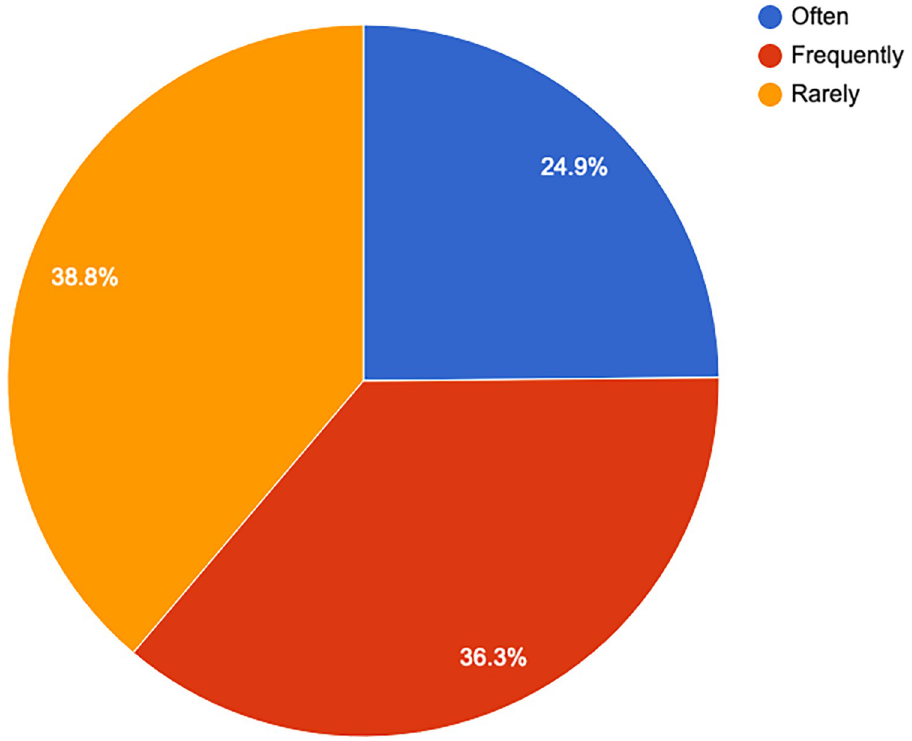
Fig 5. Religiosity/frequency of attending religious services.